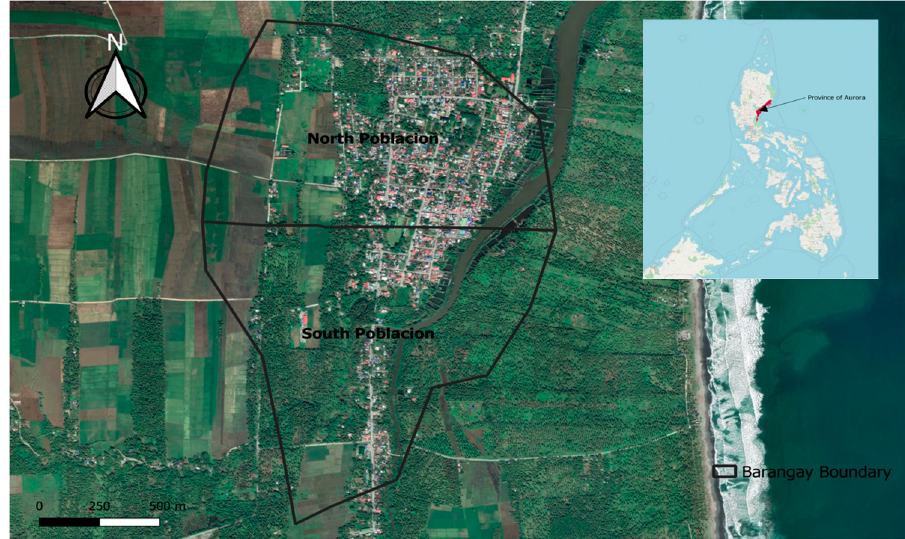
Figure 2. Location map of the study site in Dipaculao, Province of Aurora in the Philippines.